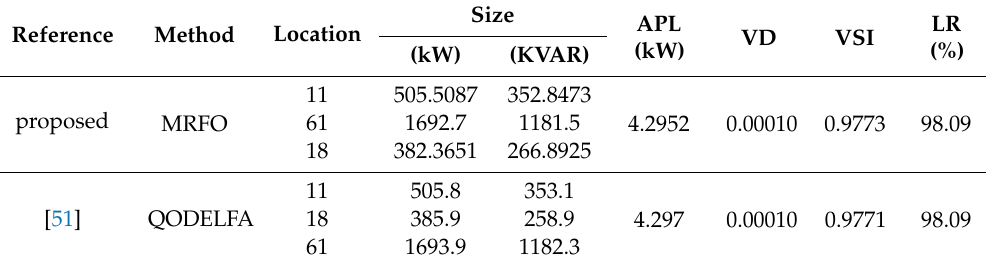
Table 8. 69-bus, three DG units, 0.82 pf.